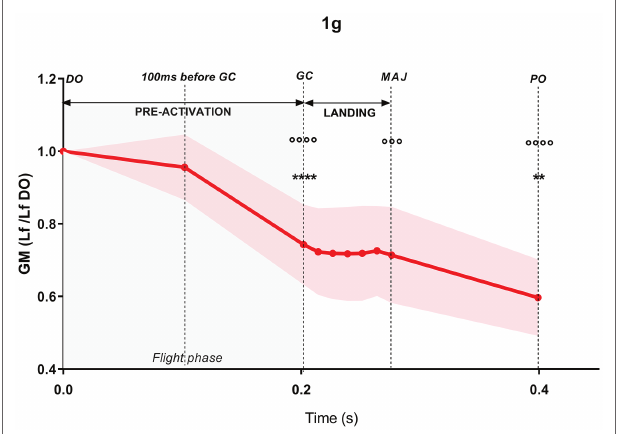
FIGURE 6 | Time course of the gastrocnemius medialis (GM) fascicle length (Lf) variations during drop jumps in 1 g. Values are normalized to drop-off (DO) Lf. Results shown as mean ± SD of maximum three jumps per gravity level per subject. ** p < 0.01 vs. previous jump time point; **** p < 0.0001 vs. previous jump time point; °° p < 0.001 vs. DO; °°°° p < 0.0001 vs.